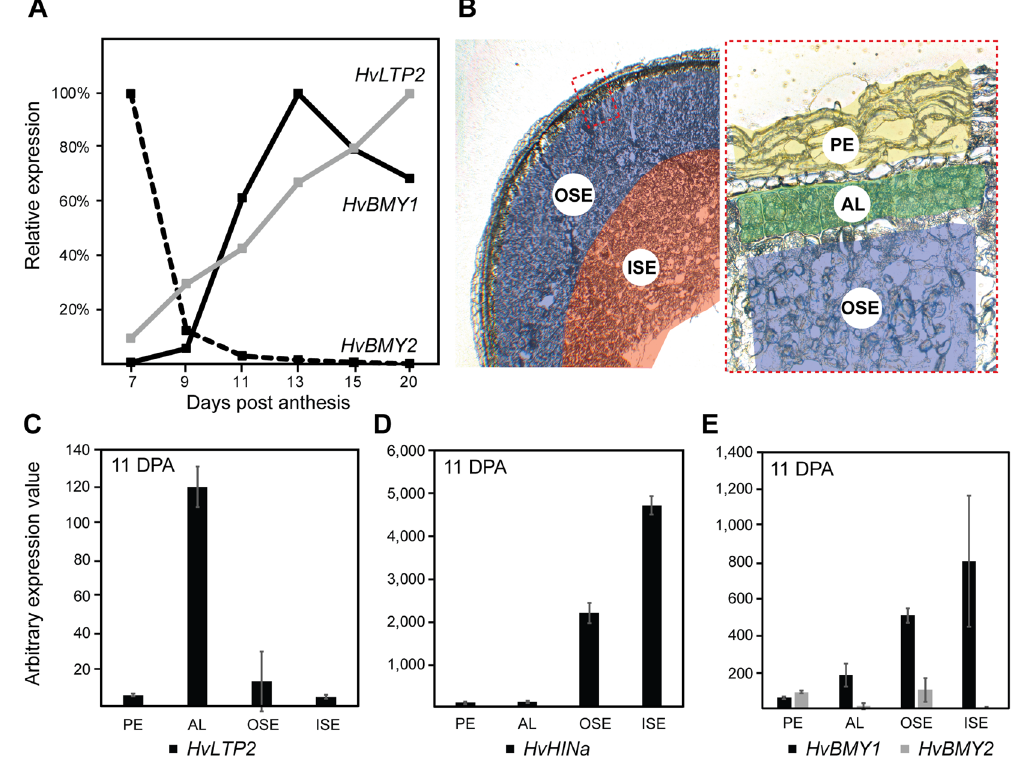
Figure 5. Accumulation of transcript in different barley grain tissues. ( A ) RNAseq analysis of transcripts from Sloop wholegrain samples, minus embryo, at 7, 9, 11, 13, 15, 20 days post anthesis (DPA). Accumulation patterns for the HvBMY1 , HvBMY2 and HvLTP2 transcripts are shown, normalised to the maximum expression value for each gene. ( B ) Thin butyl-methyl methacrylate sections of Sloop barley grain at 11 DPA showing the regions collected by laser microdissection. PE, pericarp; AL, aleurone; OSE, outer starchy endosperm including sub-aleurone; ISE, inner starchy endosperm. The red dashed box shows a magnified view of the outer grain layers. ( C – E ) Quantitative PCR analysis of transcript abundance in RNA collected from laser micro dissected material. ( C ) lipid transfer protein 2 ( HvLTP2 ). ( D ) hordoinoline a ( HvHINa ) ( E ) β -amylase 1 ( HvBMY1 ) and β -amylase 2 ( HvBMY2